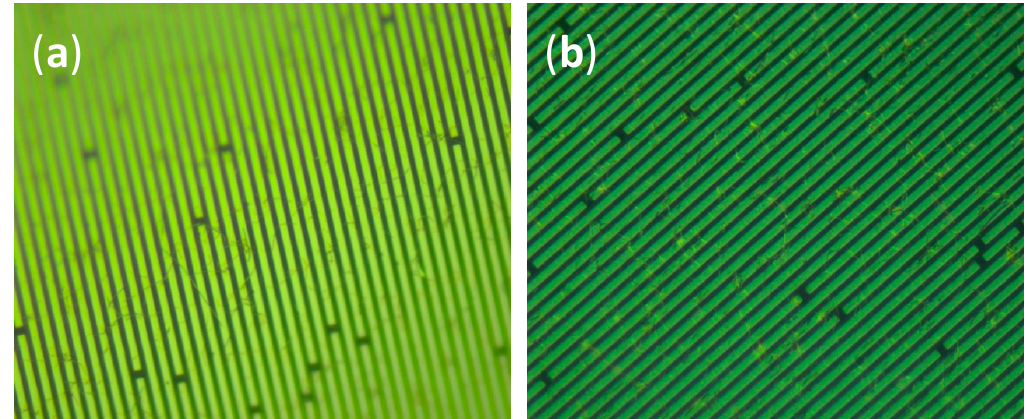
Figure 4. Optic microscope photos of IDTs coated with AgNWs by the electrospray coating method. ( a ) Sensor S6; ( b ) Sensor S7.